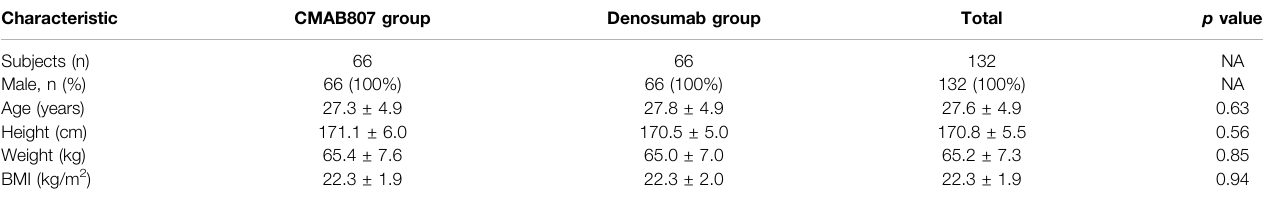
TABLE 1 | Demographic characteristics of the study subjects.